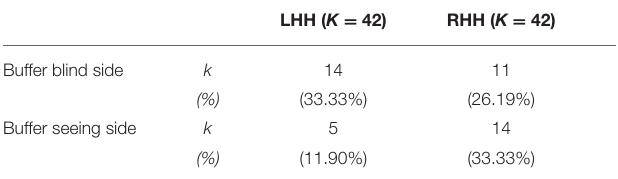
TABLE 1 | Number and percentage of intersections where the participants held a lane position that introduced a buffer on the blind or seeing side for both simulated VFL